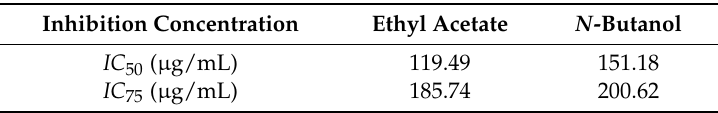
Table 4. IC 50 and IC 75 values of the extracts against C6 cell.